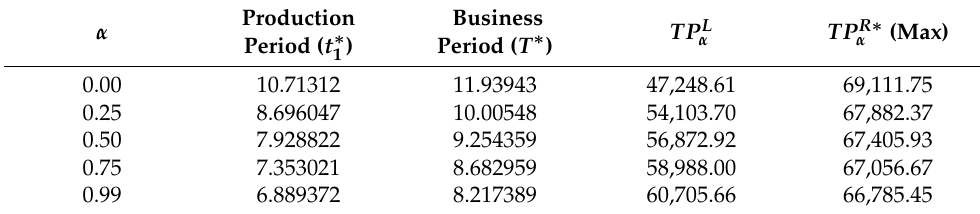
Table 12. Optimum results of Example 4 for maximizing TP R α .